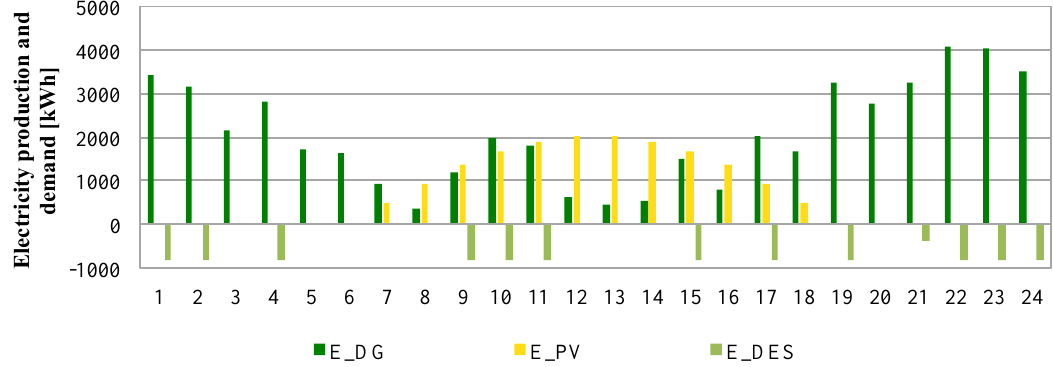
Figure 16. Optimal daily schedule of diesel generators and desalination units in May (minimum load month) in the TO-BE scenario 2. In this figure E_DG is the variable E DG , E_PV is the variable E PV and E_DES is the variable E DES.